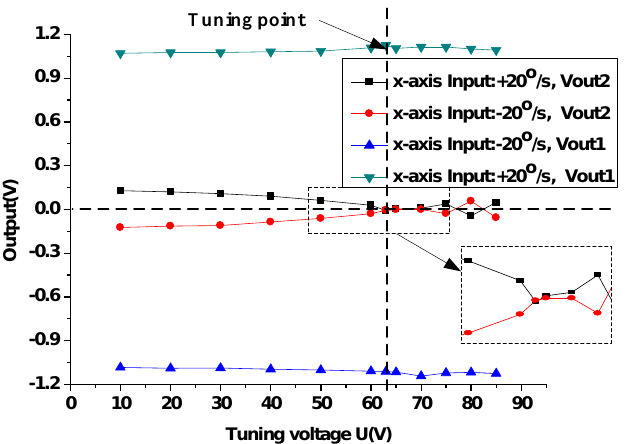
Figure 15. Open-loop tuning